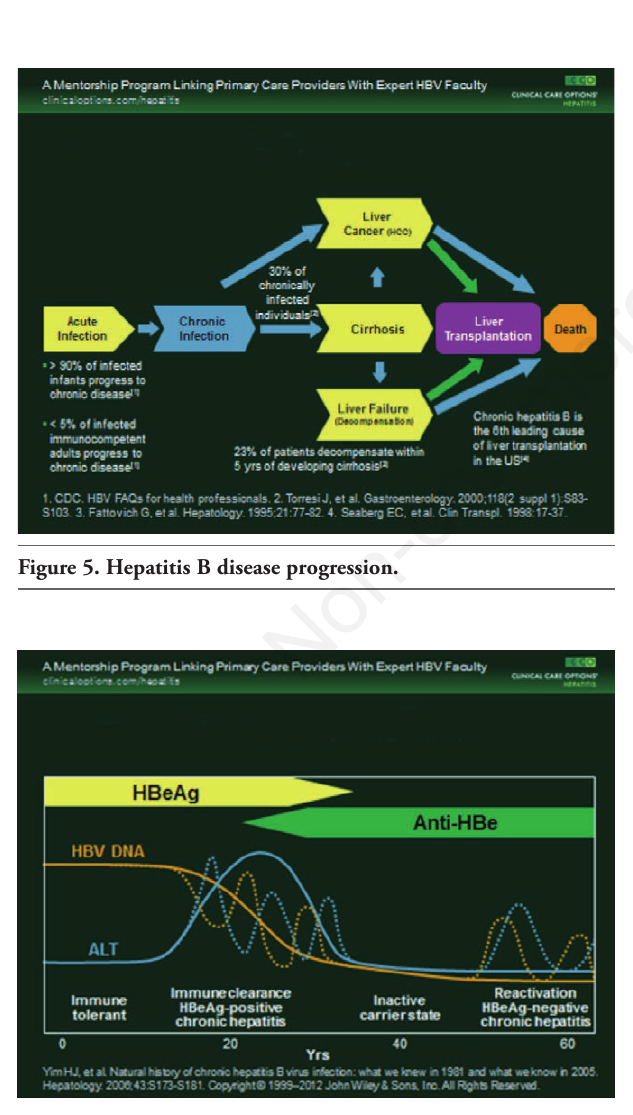
Figure 9. Cumulative incidence of HCC by serum HBV DNA level at study